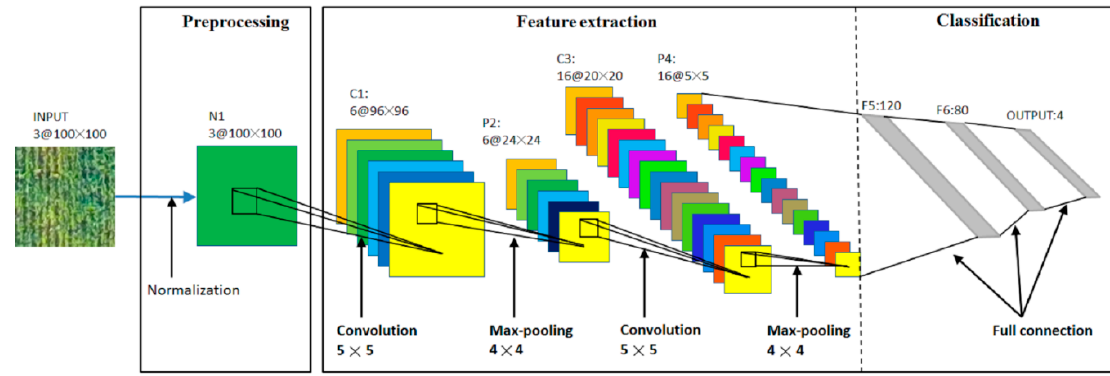
Figure 5. The architecture of our convolutional neural networks (CNN) for Helminthosporium leaf blotch (HLB) disease classification. In the first module, batch normalization is performed to the input image. In the second module, feature extraction is applied to the normalized image. In this section, convolutional layer and max-pooling layer is abbreviated as C and P, respectively. C1:6@96 × 96 means this is the first layer, and it is a convolutional layer composed of six feature maps, each of which is in size of 96 × 96. In the third module, three fully connected layers are used for classification. In this section, fully connected layer is abbreviated as F. For example, F5:120 means this is a full connection layer. It is the fifth layer and has 120 neurons.